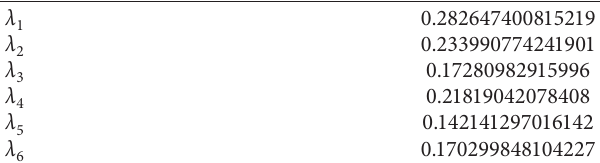
Table 5: The parameters of the DBGM (1, N ) model in case